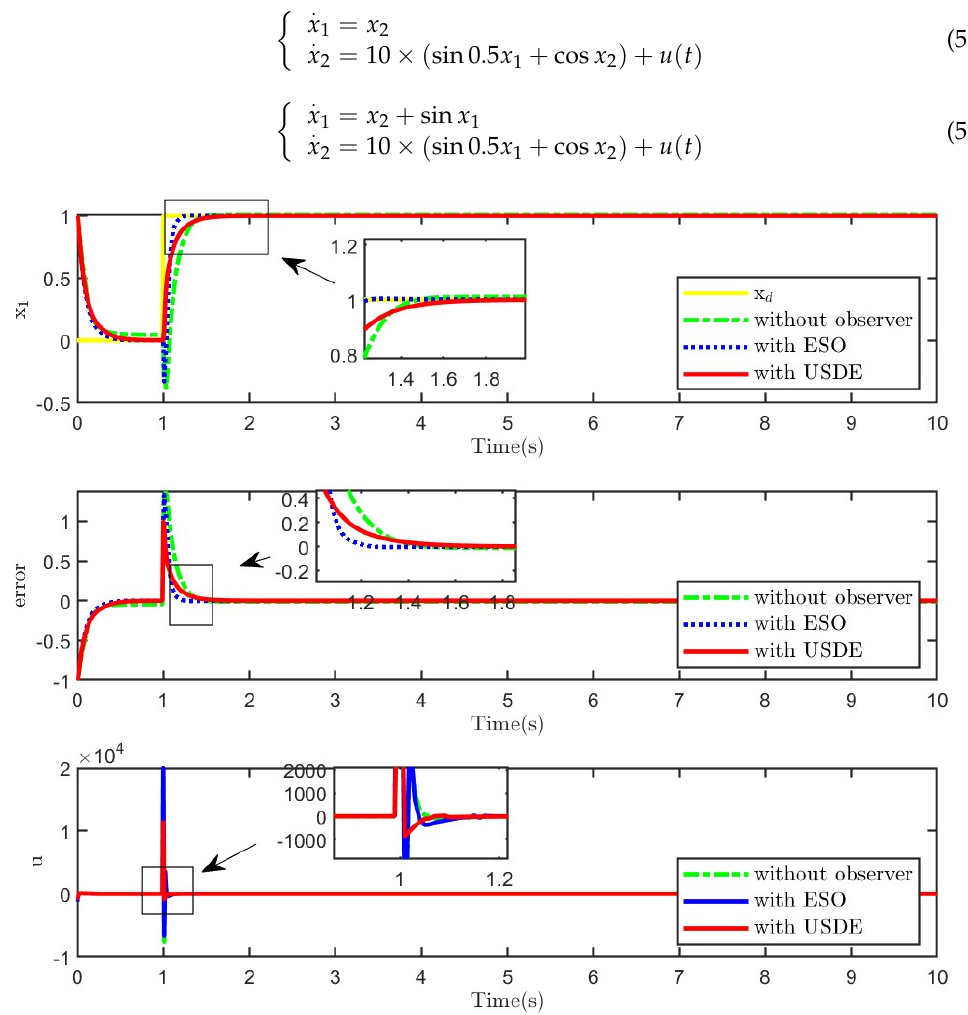
Figure 7. Tracking results of the system with matched uncertainty under the step signal.